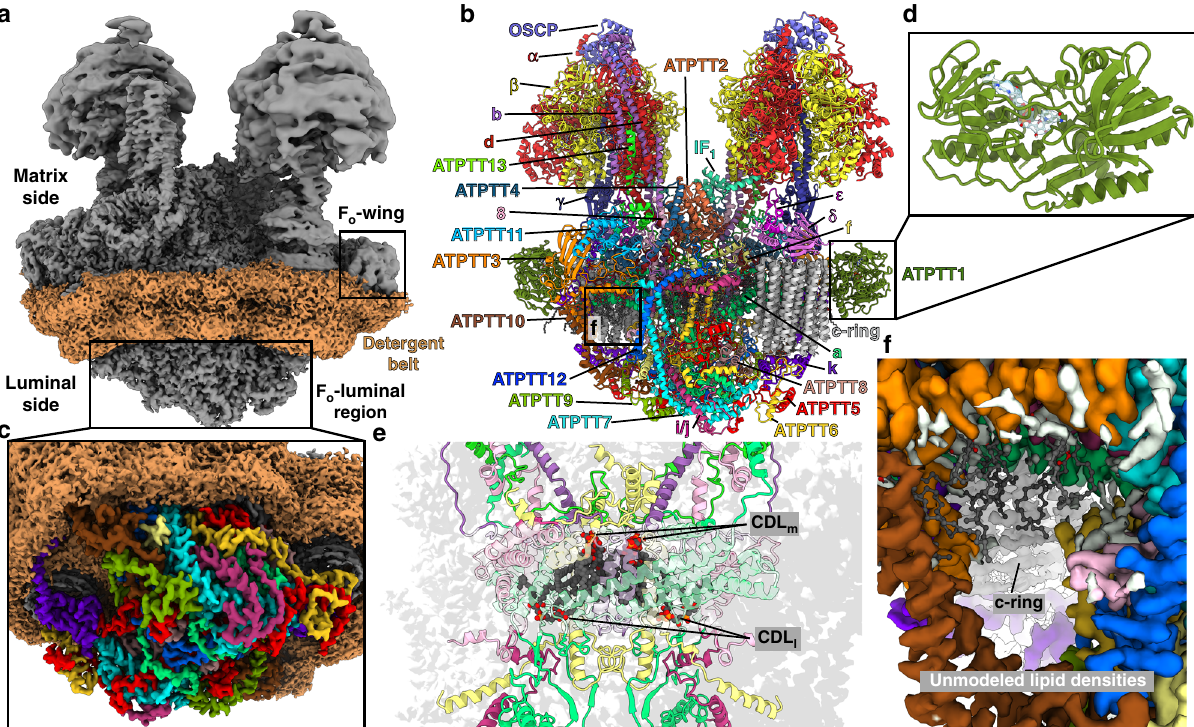
Fig. 1 Structure of type III ATP synthase dimer with bound native lipids. a Local-resolution fi ltered cryo-EM density map of the ATP synthase dimer with detergent belt. b Composite model of ATP synthase dimer with colored subunit labels. Black windows highlight regions for close-up views in panels d and f. c Cryo-EM density map of type III speci fi c F o -luminal region colored as in b . d Close-up view of F o -wing subunit ATPTT1 showing the bound NAD co-factor. e Cardiolipins sequestered in the F o -subcomplex. CDL m corresponds to matrix lea fl et lipids, CDL l corresponds to luminal lea fl et lipids. f F o cavity extending towards c-ring. Cryo-EM density map is colored by subunits, modeled lipids are shown as stick-balls. Unmodeled lipid-density map features are colored